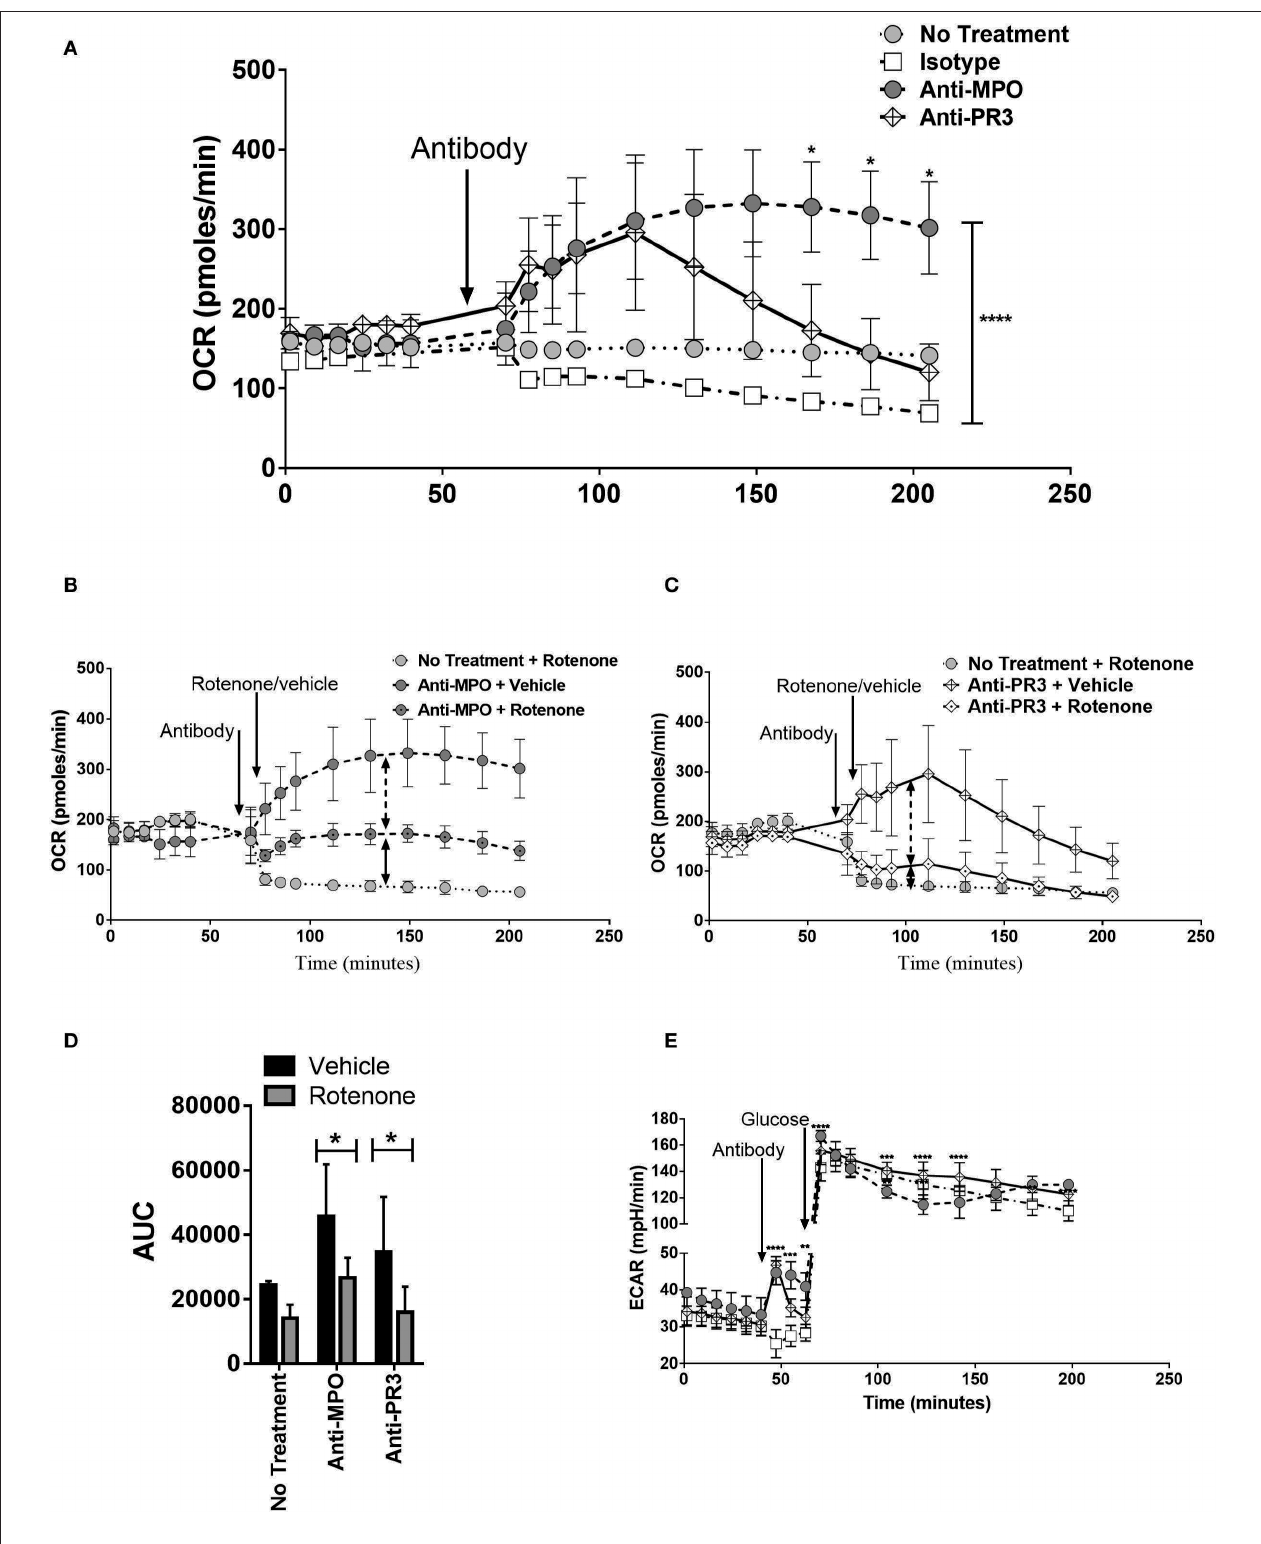
FIGURE 4 | Anti-MPO and anti-PR3 stimulated monocytes have differing OCR and ECAR kinetic patterns. OCR of CD14 + monocytes was measured at regular intervals following the addition of 5 µ g/ml mAb directed against MPO (A,B) , PR3 (A,C) or isotype control antibody (A–C) by Seahorse extracellular flux analysis.